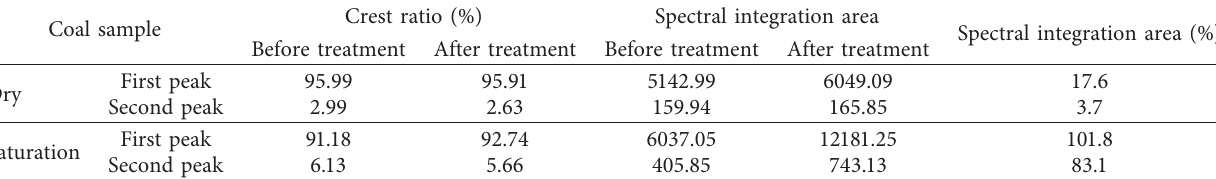
Table 2: NMR spectrum integral area